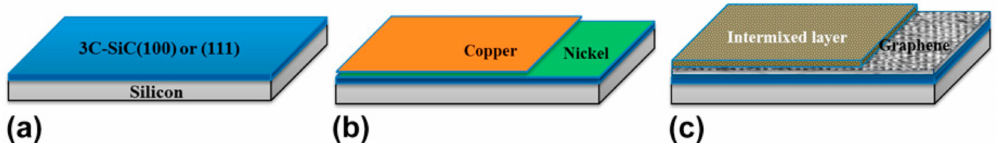
Figure 5. Epitaxial growth for graphene production. Reproduced with permission from [65]. ( a ) Starting substrate; ( b ) Deposit catalyst layer of Ni or Ni and Cu on starting substrate; ( c ) Anneal for the formation of graphene covered with intermixed layer. Copyright 2015, Cambridge University